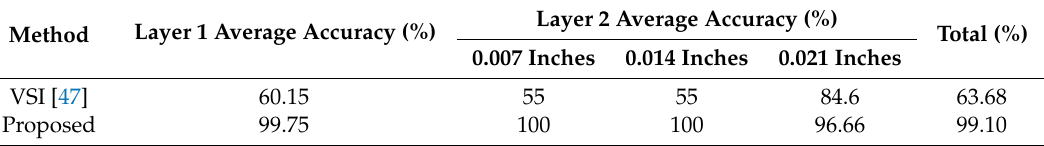
Table 4. The diagnostic performance of the proposed model and vibration spectrum imaging